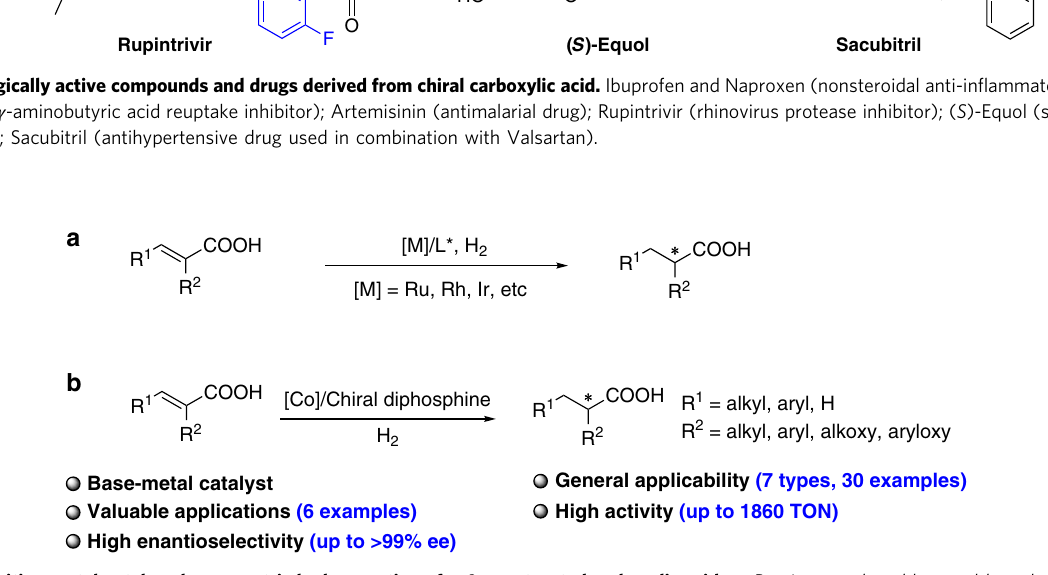
Fig. 2 Transition metal-catalyzed asymmetric hydrogenation of α , β -unsaturated carboxylic acids. a Previous work: noble metal-based catalysts. b This work: cobalt-catalyzed asymmetric hydrogenation of α , β -unsaturated carboxylic